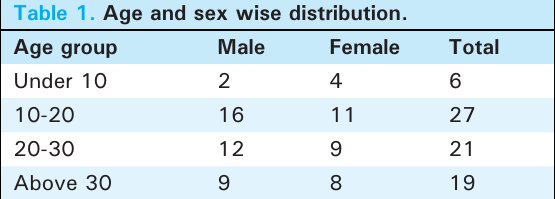
Table 1. Age and sex wise